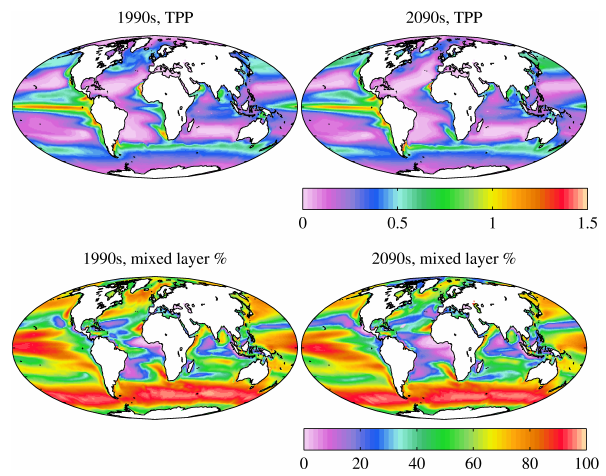
Fig. 14. Annual average 1990s (left) and 2090s (right) primary pro- Fig.12. Annualaverage1990s( left )and2090s( right )primaryproduction( top ;gCm − 2 d − 1 )andmixedlayerfraction ( bottom ;%). duction (top; gCm − 2 d − 1 ) and mixed layer fraction (bottom; %).